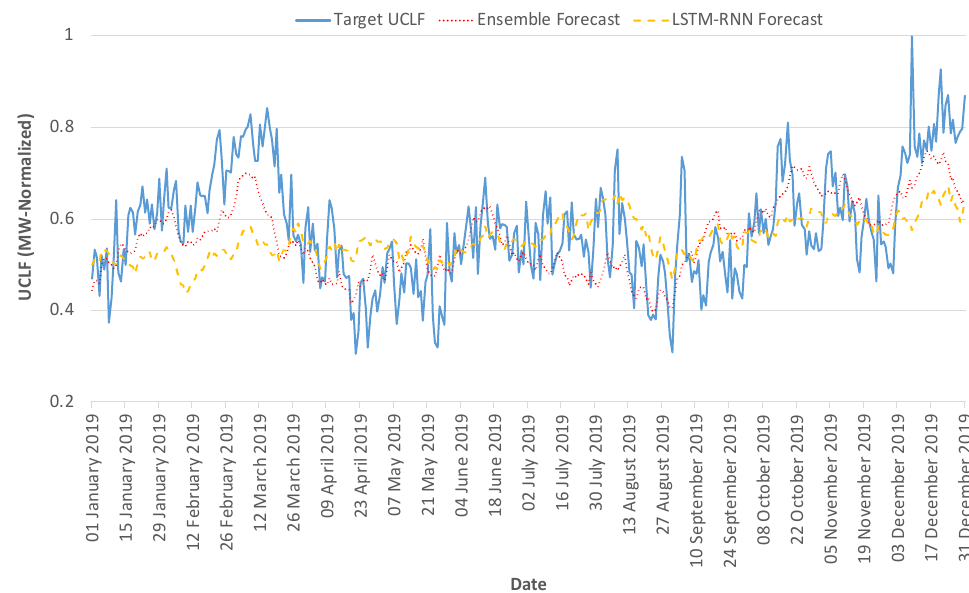
Figure 8. A plot of the OP-ELM and ensemble lowest error model year-ahead UCLF forecast against the target UCLF.